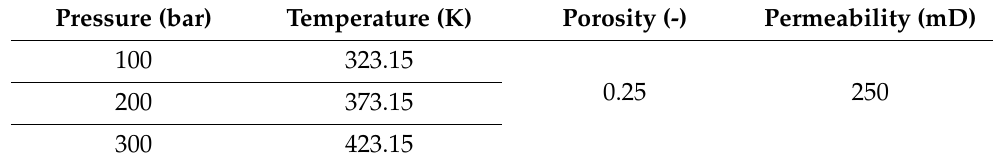
Table 1. The model